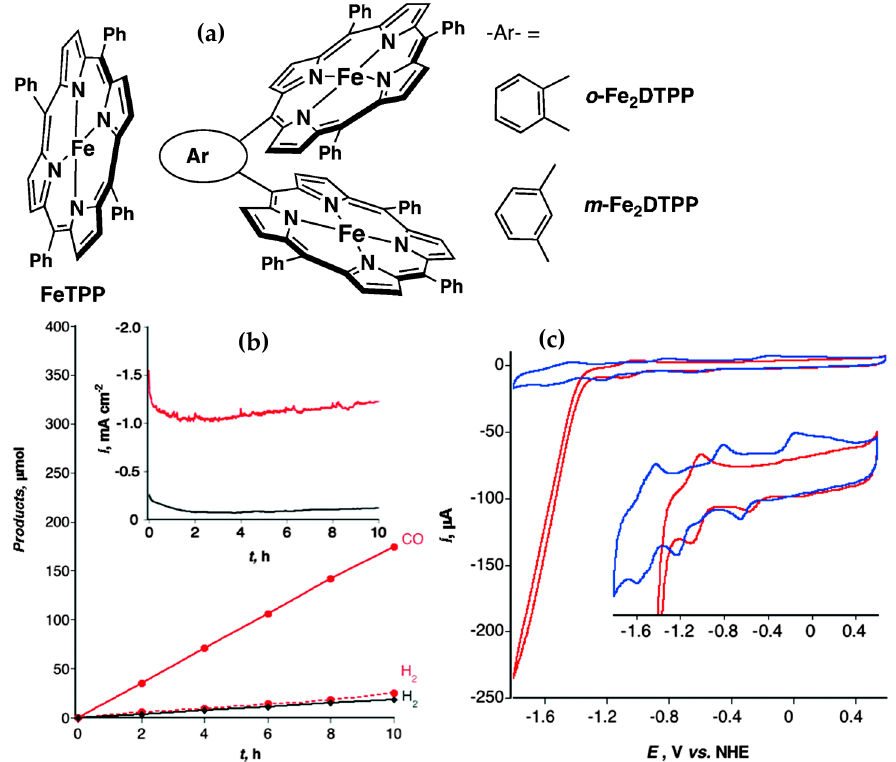
Figure 10. ( a ) Chemical structures of the iron porphyrin monomer, FeTPP, and iron porphyrin dimers, o − Fe 2 DTPP and m-Fe 2 DTPP. ( b ) CVs of o − Fe 2 DTPP at 100 mV scan rate in DMF/10% H 2 O containing 0.1 M TBAPF 6 supporting electrolyte under Ar or CO 2 . Inset: magnified trace of CVs. ( c ) CO 2 reduction products with time and the current density–time profile (inset) produced during the 10 h chronoamperometry experiment at − 1.35 V vs. NHE in a DMF/10% H 2 O/0.1 M TBAPF 6 solution saturated with CO 2 without (black lines) and with 0.5 mM o − Fe 2 DTPP (red lines). (Reprinted with permission from Ref. [128]. Copyright 2015 Royal Society of Chemistry).